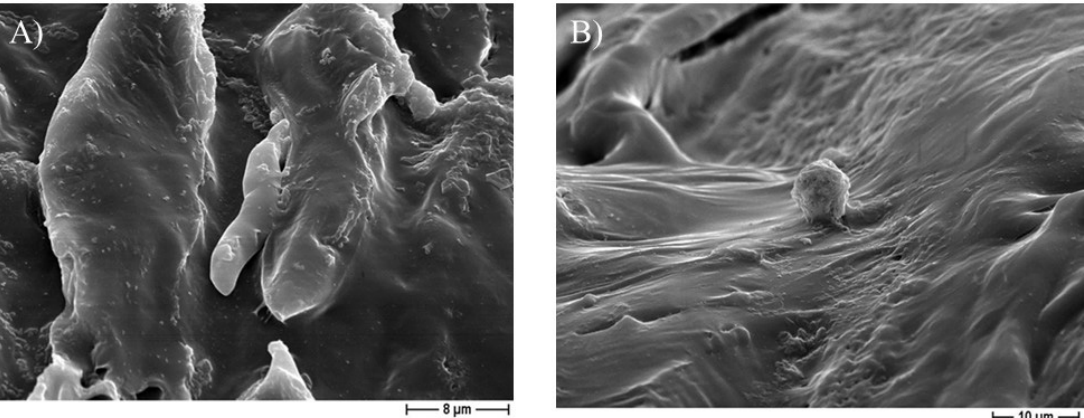
Figure 7. Representative FESEM micrographs, after six days of incubation, of the 30% cinnamon oil-added PCL 3D scaffolds obtained by using NaCl ( A ) or NaNO 3 ( B ) salt as template, showing the attachment of Saos-2 cells at 1000× or 2000× magnification, respectively.